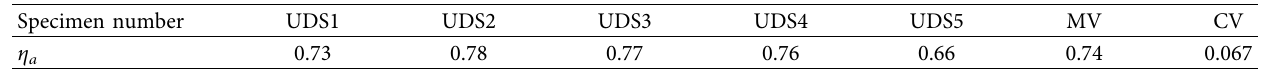
Figure 16: CFRP rod anchored by dissolution-rebond anchor after failure. (a) Specimen after failure. (b) CFRP rod after failure. Table 3: Anchorage efficiency coefficient of the dissolution-rebond